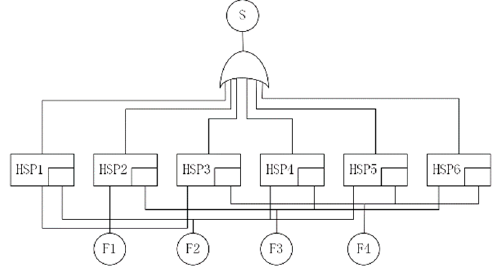
Figure 2. Pyramid allocation of a flywheel system (FS).